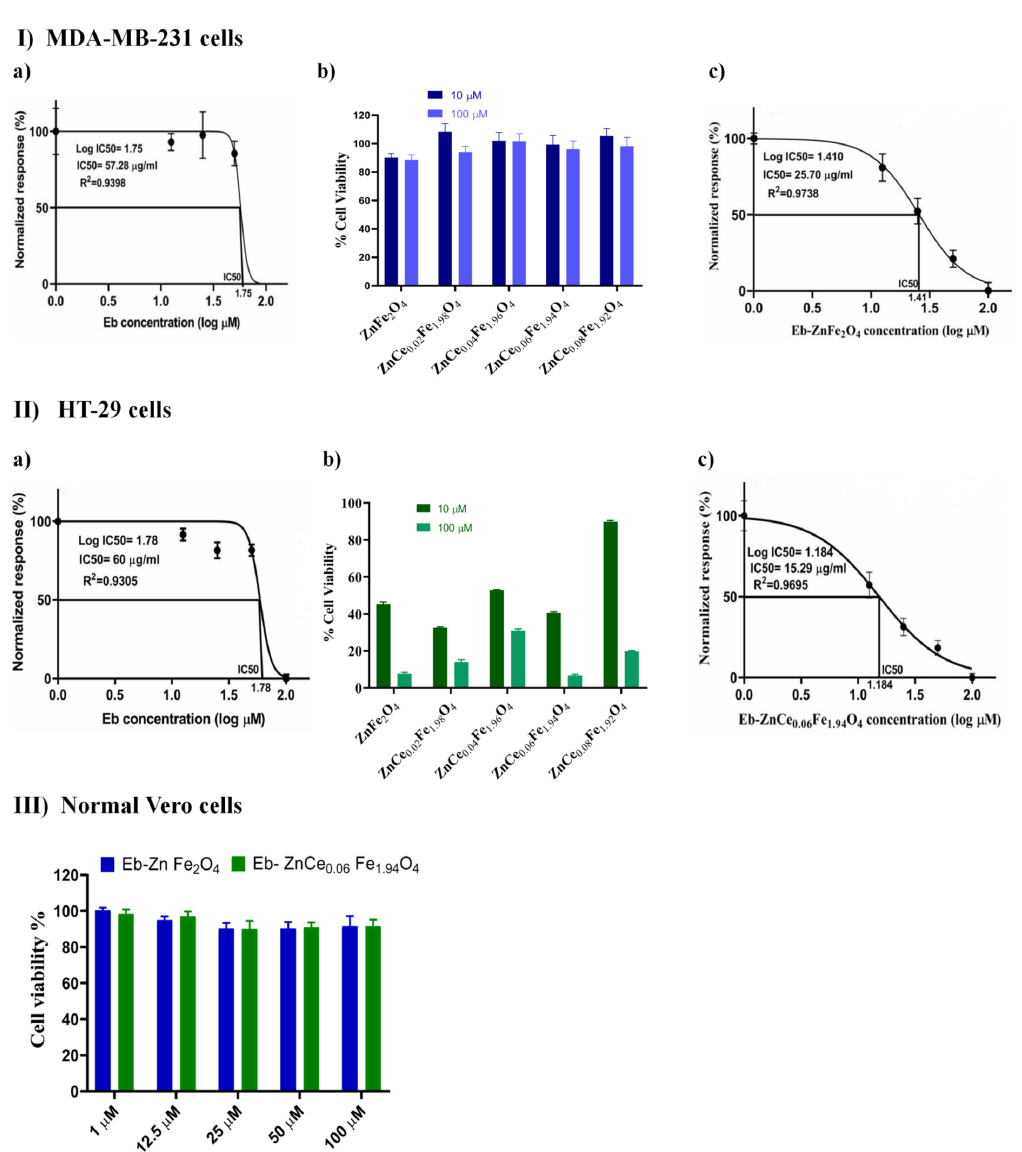
Figure 12. Cytotoxicity screening of various concentrations of Ebselen (Eb) and/or ZnCexFe 2 -XO 4 nanoparticles. ( I ) MDA-MB-231 cells treated as follows: ( a ) Eb, ( b ) ZnCexFe 2 -XO 4 , and ( c ) Eb-ZnFe 2 O 4 . ( II ) HT-29 cells treated as follows: ( a ) Eb, ( b ) ZnCexFe 2 -XO 4 , and ( c ) Eb-ZnCe 0.06 Fe 1.94 O 4 . ( III ) Normal Vero cells treated by Eb-ZnFe 2 O 4 and Eb-ZnCe 0.06 Fe 1.94 O 4 at a concentration of 100 µM. The percent survival was calculated based on untreated cells of both cell lines and was set at 100% (n = 3). Inverted light microscopy images of all the above tests are represented as shown in Figure S1 (I, II and III).